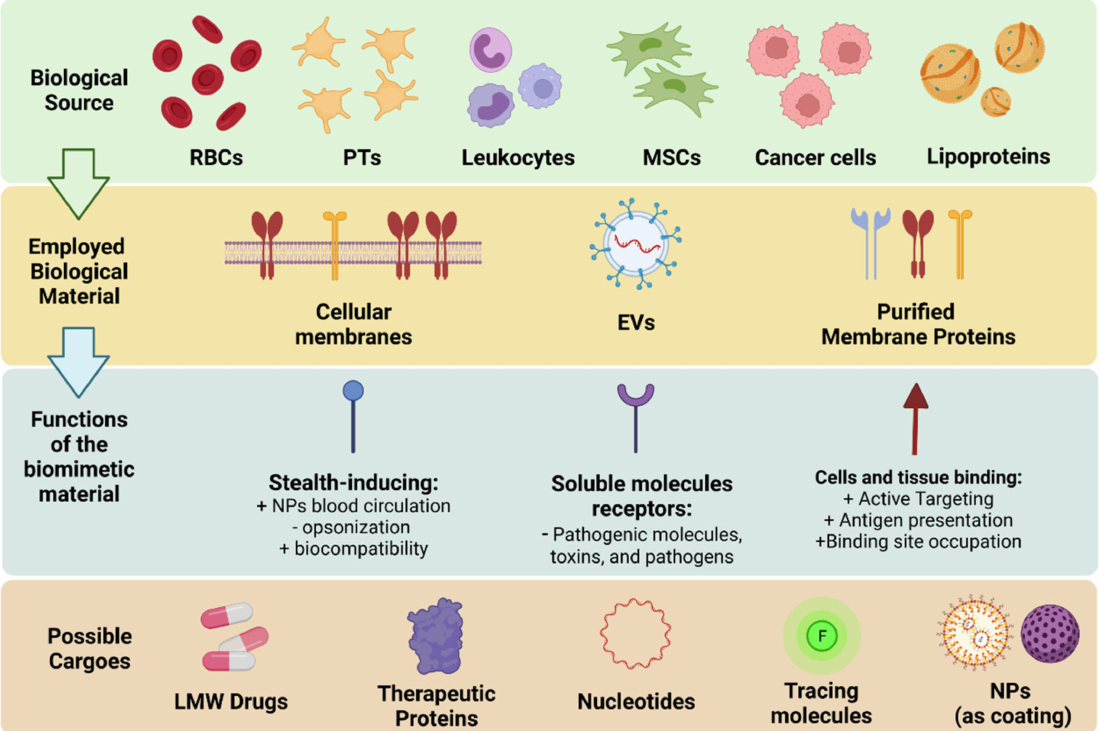
Figure 2. Schematic representation of the current biomimetic approach toolbox in term of source cells, biomimetic strategies, membrane proteins functions, and cargoes. This image was created with Biorender.com (accessed on 1 March 2022). EVs: extracellular vesicles; LMW: low molecular weight; MSCs: mesenchymal stem cells; NPs: nanoparticles; PTs: platelets; RBCs: red blood